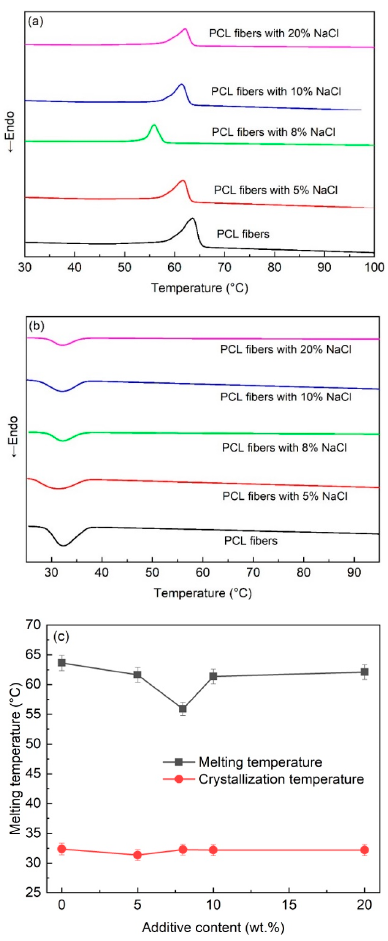
Figure 3. DSC thermograms of PCL fibers with different additive content: ( a ) heating and ( b ) cooling. ( c ) The melting and crystallization temperature of the PCL fibers derived from the DSC thermograms.